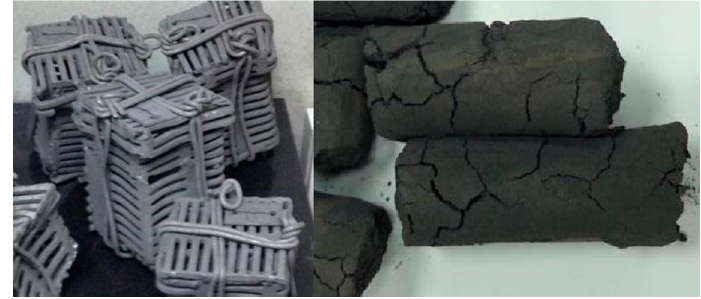
Figure 4. Rigid baskets for brex and the reduced cement-bonded brex after their extraction.